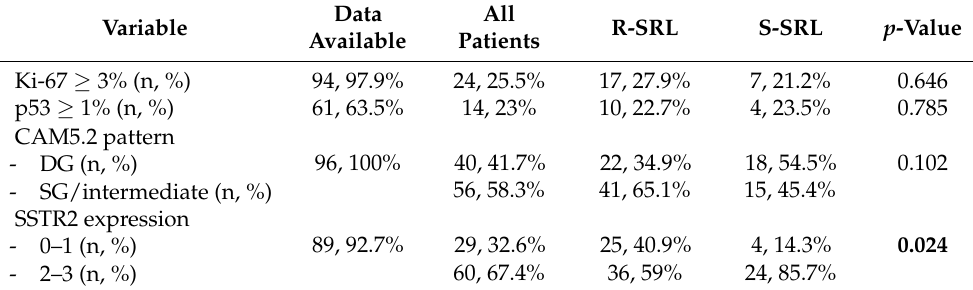
Table 5. Histological and molecular features of operated GH-secreting tumors. Variable